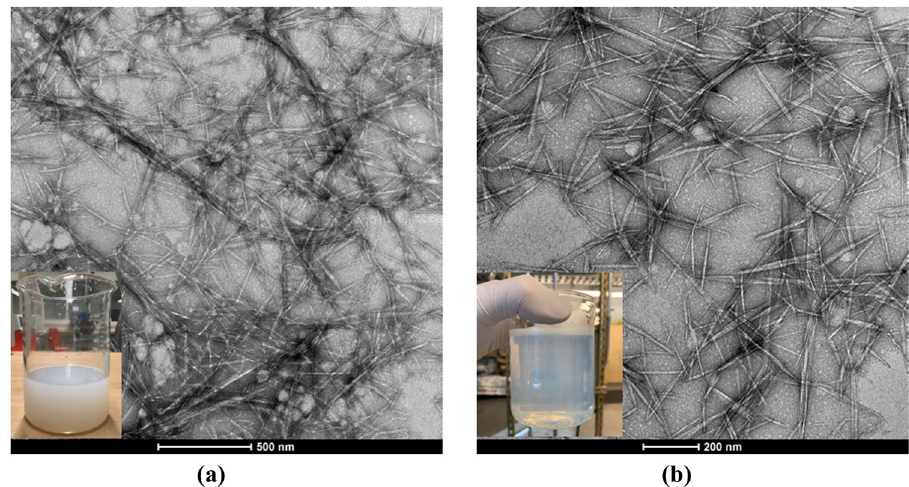
Figure 6: ( a ) TEMPO - oxidized chitin nano fi bers ( 3 mmol NaClO/g chitin ) ; ( b ) TEMPO - oxidized chitin nanocrystals ( 9.5 mmol NaClO/g chitin )